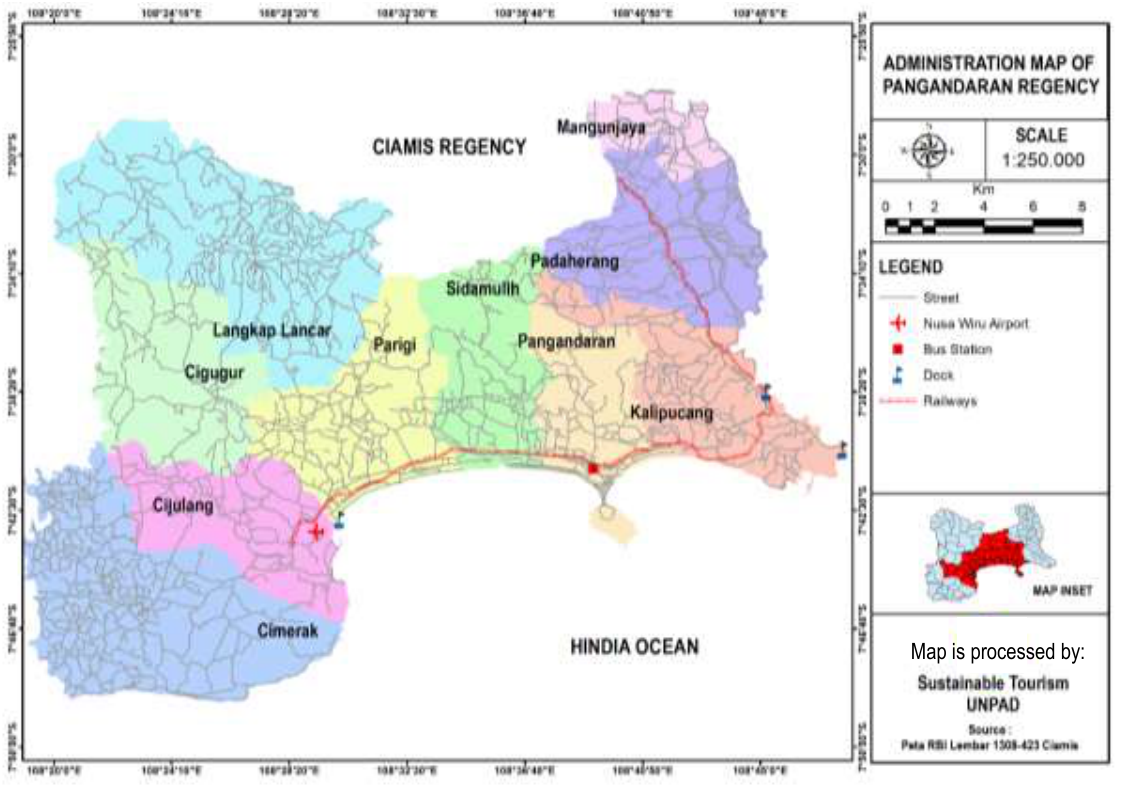
Figure 1. Map of Pangandaran Regency Administration (Source: Processed by researchers, 2019